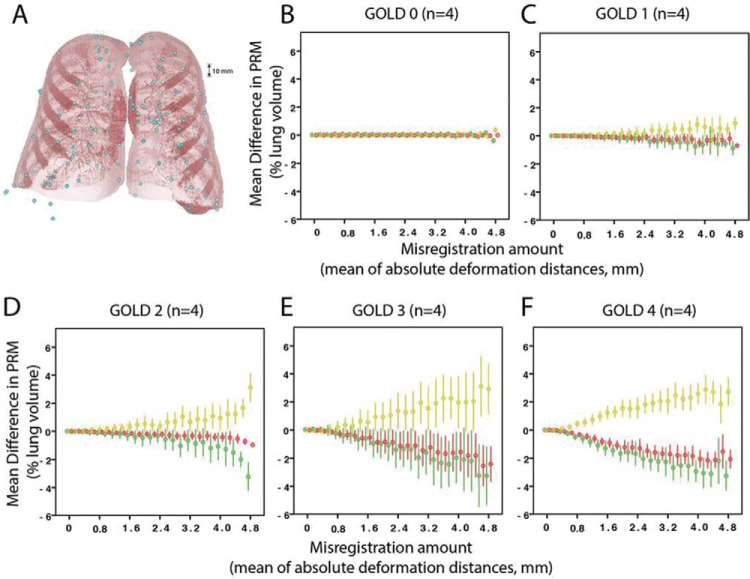
Impact of misregistration on PRM. Misregistration is simulated using a feature set (aqua dots) shown on a sample lung volume (A) that is moved slightly to deform a good registration solution (4 each; Gold stages 0 to 4). Changes in PRM increase as the mean absolute misregistration across the feature set increases. PRM changes are pooled by GOLD stage and represent mean ± SD differences (B–F). Note that mean changes of 2.5 mm may include local deformation regions of up to 7.5 mm or approximately 10 voxels.